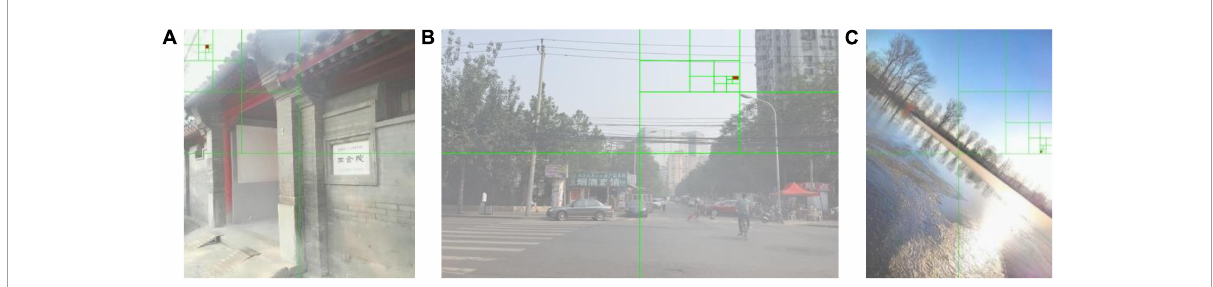
FIGURE5 Estimation of global atmospheric light using an optimized quadtree segmentation